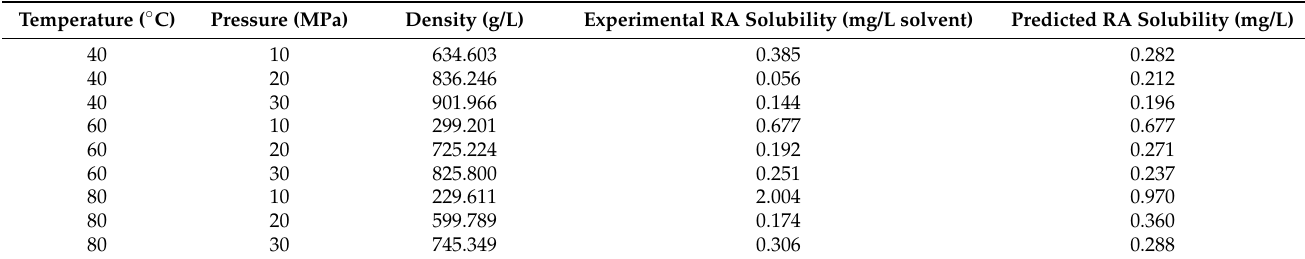
Table 2. Solubility data of RA at various temperatures and